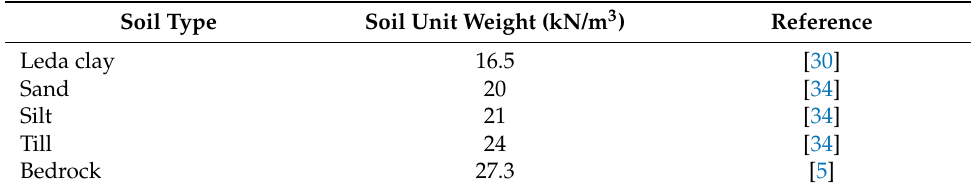
Table 2. Characteristics of soil properties of Montreal